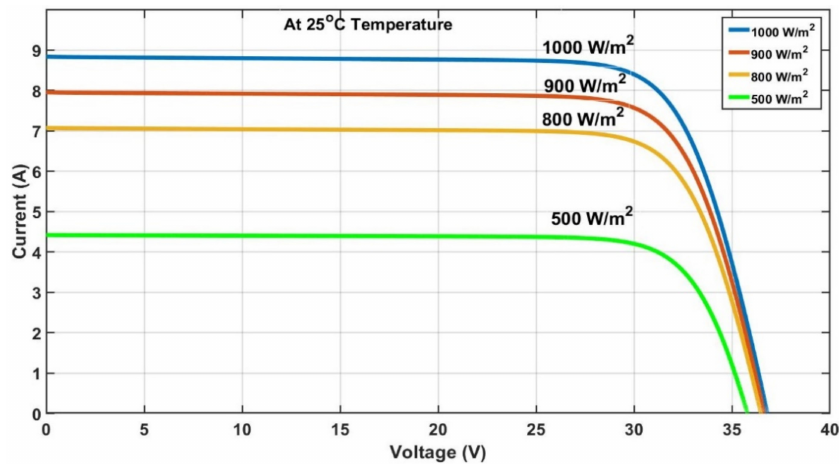
Figure 9. I-V curves with different irradiances at 25 ◦ C.